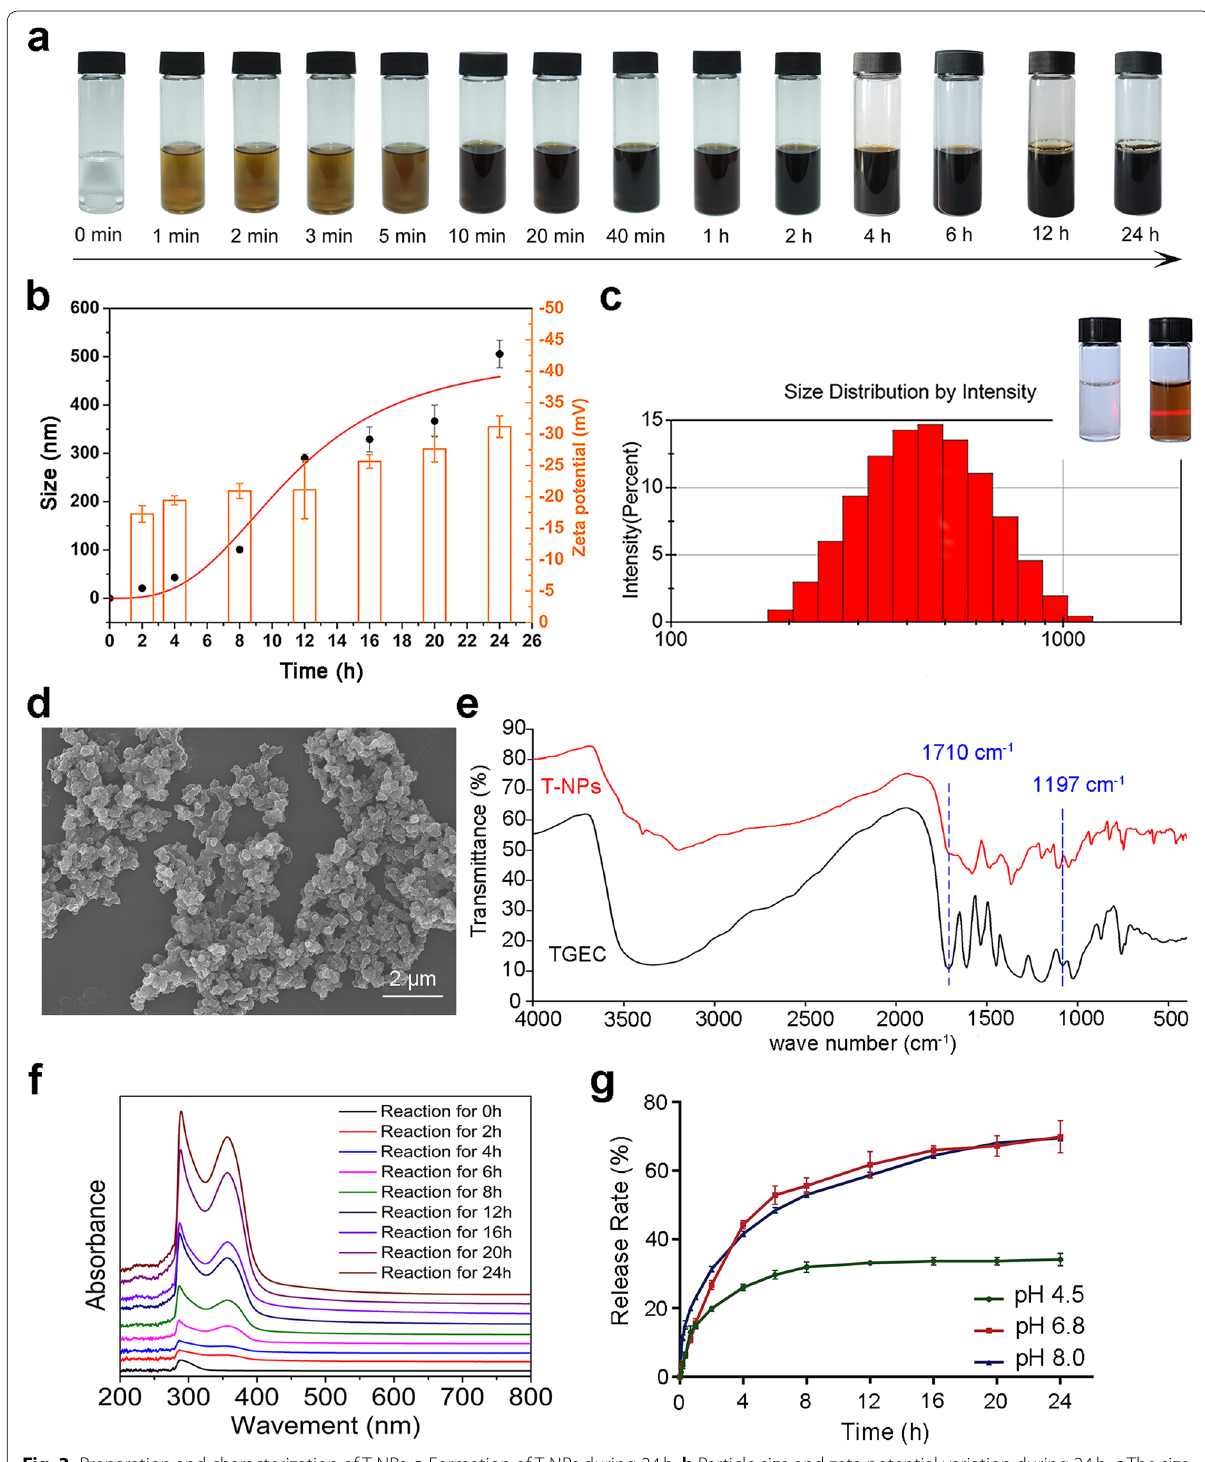
Fig. 3 Preparation and characterization of T-NPs. a Formation of T-NPs during 24 h. b Particle size and zeta potential variation during 24 h. c The size distribution of T-NPs at reaction 24 h. The Tyndall effect of TGEC (left) and T-NPs solution (right) at reaction 4 h was shown in inset photo of 3C. d SEM image of T-NPs at reaction 24 h. e Infrared spectrum absorption of TGEC (black) and T-NPs (red). f The UV-Vis spectrum of TGEC (black curve) and T-NPs (red curve). g The accumulated release rate of T-NPs in artificial saliva with different pH